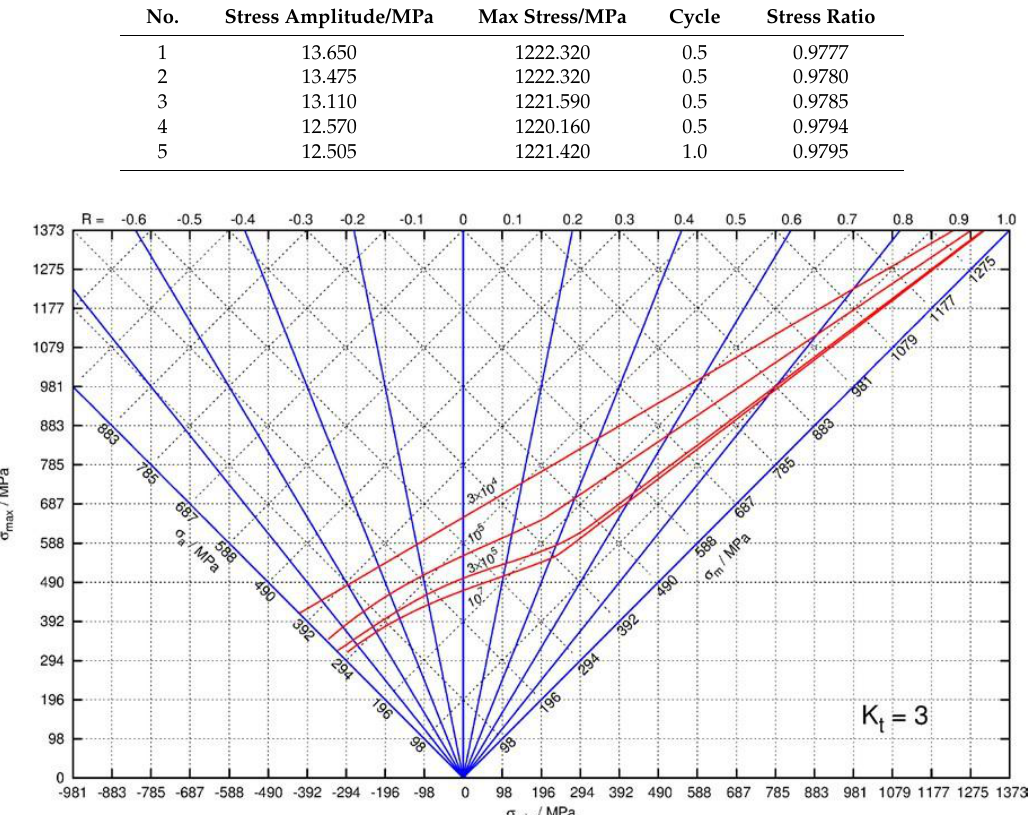
Figure 9. Constant life curve of K t = 3 based on median fatigue life.